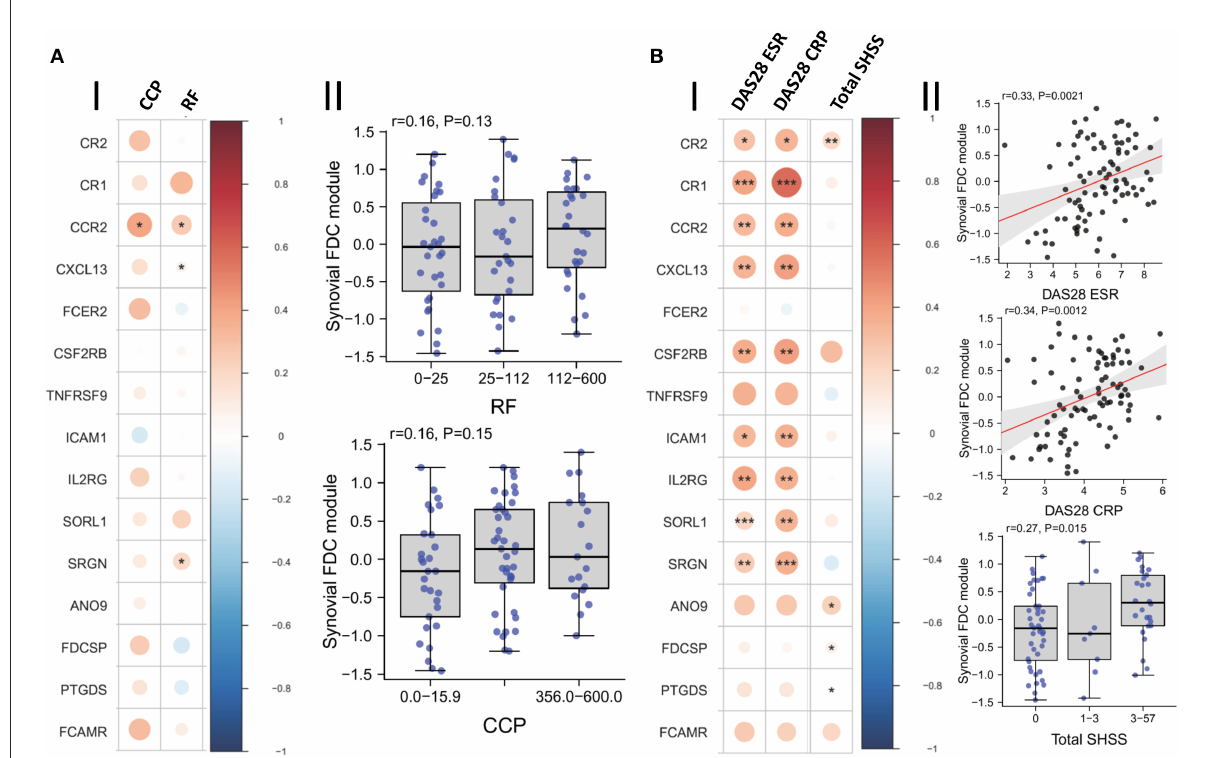
FIGURE7 Correlation of synovial FDCs with the RA clinical parameters: (A-I) Correlation plot of the individual FDC genes against baseline CCP (anti-cyclic citrullinated peptide antibody titer) and RF (rheumatoid factor titer). (A-II) Boxplots demonstrating the correlation of RF and CCP titers with the overall synovial FDC genes module. (B-I) Correlation plot of the individual FDC genes against DAS28-ESR (28-joint Disease Activity Score for rheumatoid arthritis with Erythrocyte Sedimentation Rate); DAS28-CRP (C Reactive Protein), and Sharp van der Heijde score (SHSS). (B-II) Correlation of DAS28-ESR; DAS28-CRP, and SHSS with the overall synovial FDC genes module. p -values were calculated using Spearman rank test, * P < 0.05, ** P < 0.01, *** P < 0.001. r = Spearman rho correlation coefficient, p = significance value.